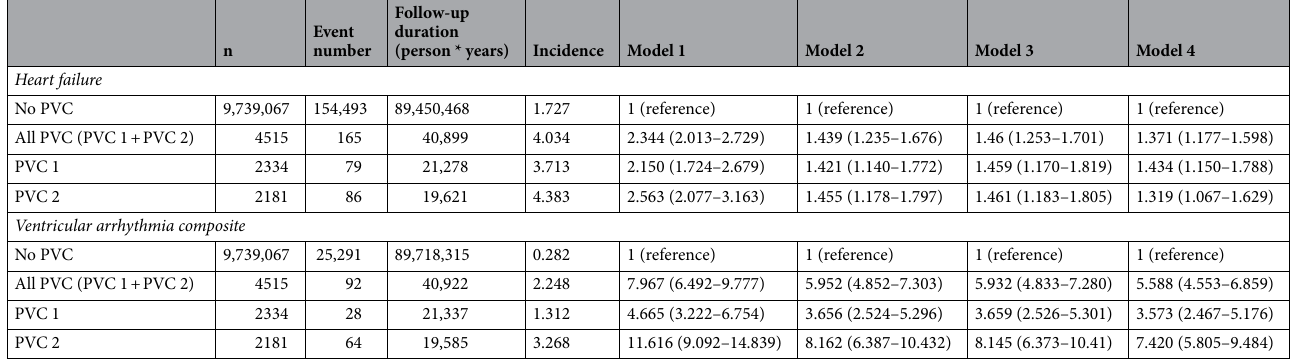
Table 2. Incidence of heart failure and ventricular arrhythmia composite in people with PVC. Incidence is per 1000 person * years. Model 1 is without multivariate adjustment. Model 2 is adjusted for age and sex. Model 3 is adjusted for age, sex, BMI, smoking status, alcohol consumption, and physical activity. Model 4 is adjusted for age, sex, BMI, smoking status, alcohol consumption, physical activity, hypertension, diabetes, and dyslipidemia. AF atrial fibrillation, PVC premature ventricular contraction.